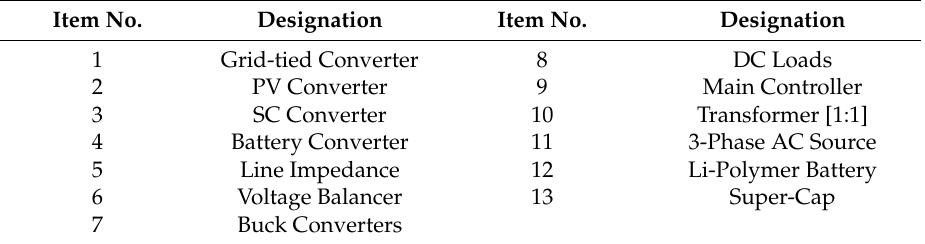
Figure 15. Hardware experimental set-up. Table 4. Hardware set-up for the